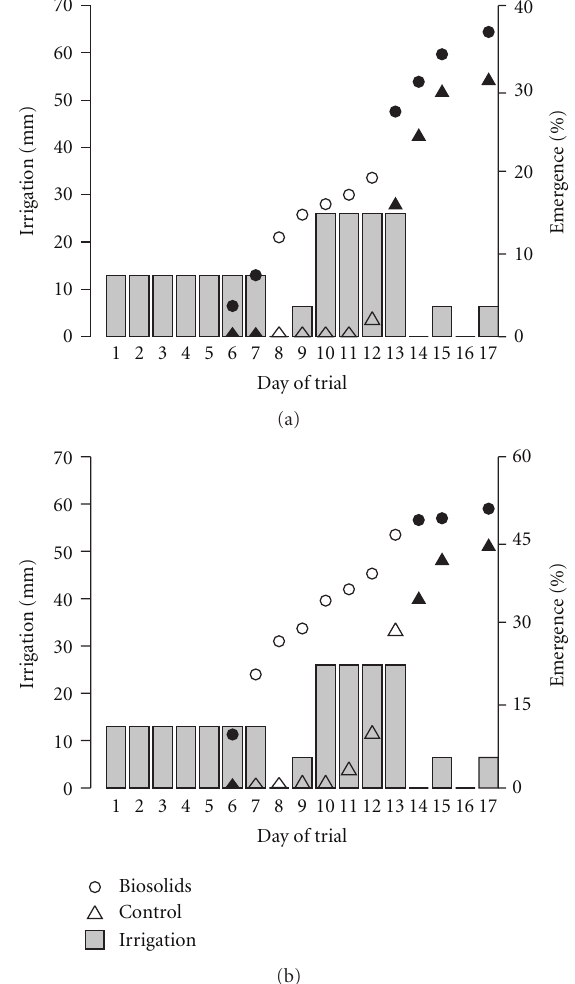
Figure 4: (a) Bouteloua gracilis and (b) Leptochloa dubia seedling emergence as a ff ected by 0 or 34 Mgha − 1 . Treatment means for a species on a given date with open symbols are significantly di ff erent (redrawn from